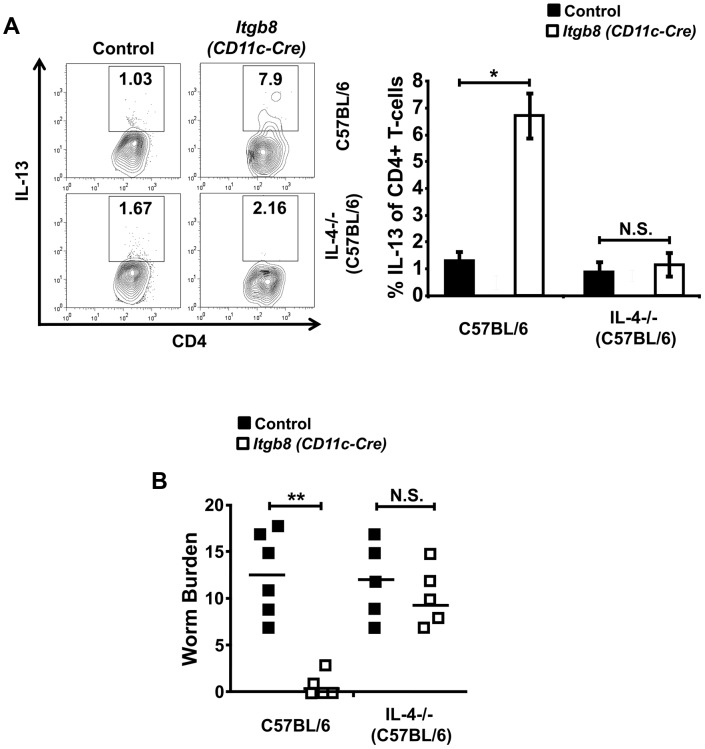
Ablation of enhanced IL-13 production by CD4+ T-cells in Itgb8 (CD11c-Cre) mice restores susceptibility to infection with T. muris.(A) IL-13 production by LILP CD4+ T-cells isolated day 3 post-infection (p.i.) with a chronic dose of T. muris eggs in IL-4−/− control and Itgb8 (CD11c-Cre) IL-4−/− mice. Representative flow cytometry plots and mean data are displayed. Data (n = 5–6 mice per group) are from two independent experiments. Data (n = 5–6) are from two independent experiments performed. (B) Worm burdens from IL-4−/− and Itgb8 (CD11c-Cre) IL-4−/− mice at day 14 p.i. with a chronic dose of T. muris eggs. Data (n = 5–6 mice per group) are from two independent experiments. **, P<0.01; N.S., not significant via Student's t –test for the indicated comparisons between groups, error bars represent SE of means.